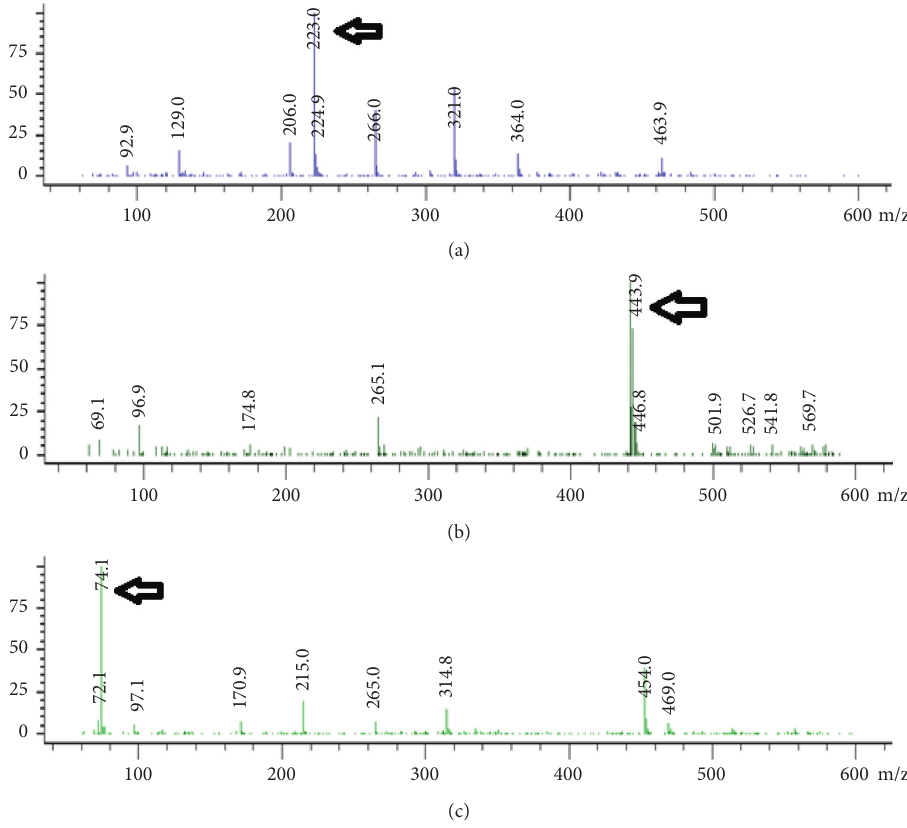
Figure 3: The mass spectra for the three components with their m / z (74.1, 223.0 and 443.9 for 6-APA (c), AMOX (a), and DIC (b), respectively). Table 2: Determination of AMOX and DIC in Miclox ® capsules (Batch no. 001011) by the proposed HPLC/MS method and application of standard addition technique. AMOX DIC Taken ( µ g mL − 1 )